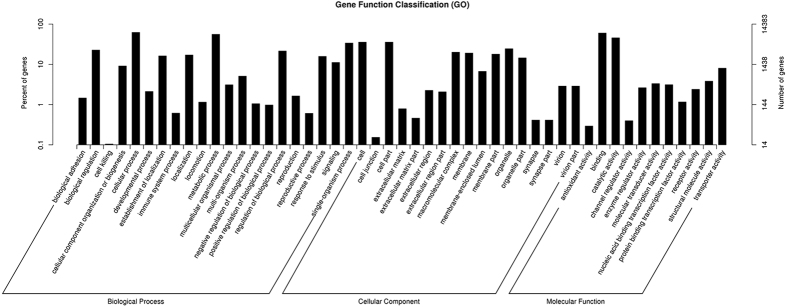
Gene ontology classifications of the Chilo suppressalis unigenes.The results were summarized in three main categories: biological process, cellular component, and molecular function. The right y-axis indicates the number of genes in the category. The left y-axis indicates the percentage of a specific category of genes in that main category.